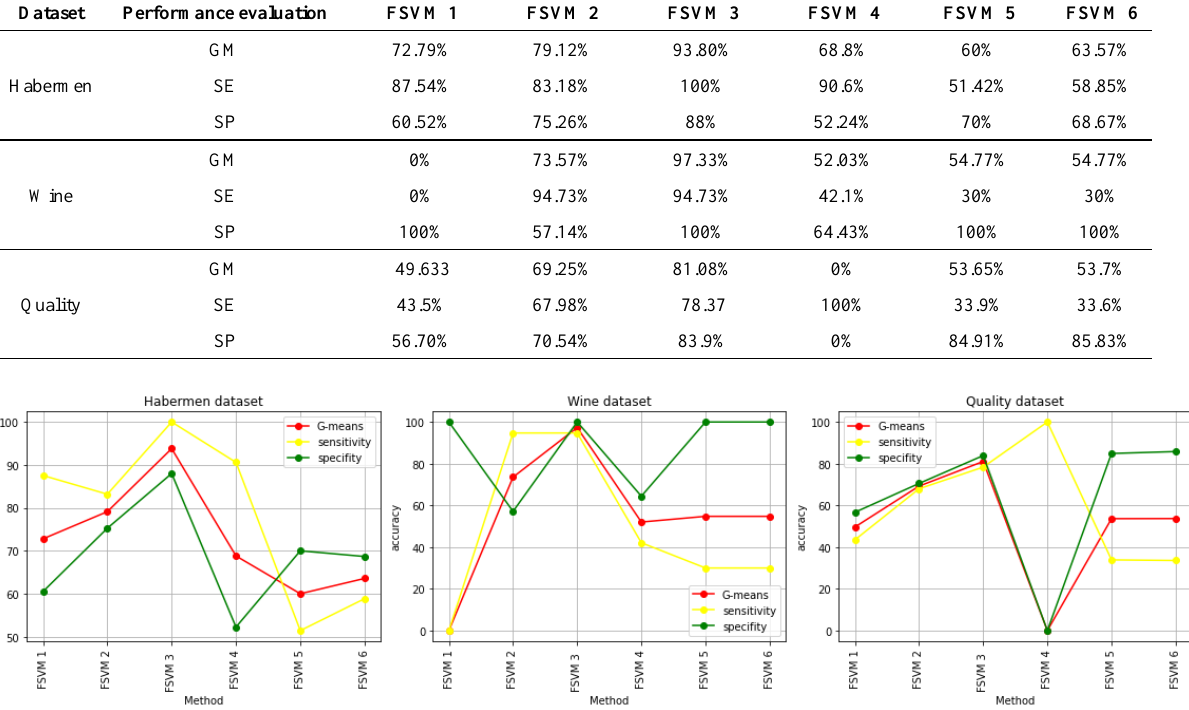
Table 4. Model performance evaluation